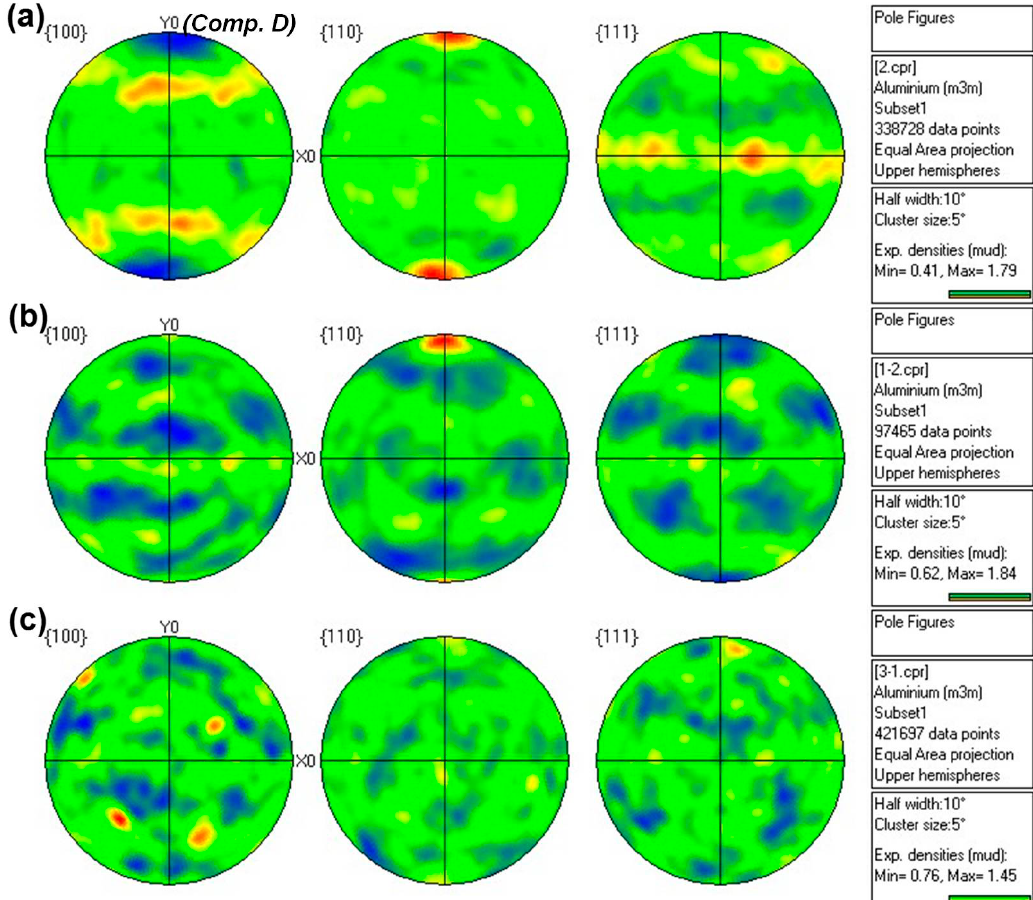
Figure 11. Pole figure of γ phase for the alloy prior to ( a ) and after compression deformation under 1000 ◦ C with the strain rate of 10 − 2 s − 1 ( b ) and 10 − 4 s − 1 ( c